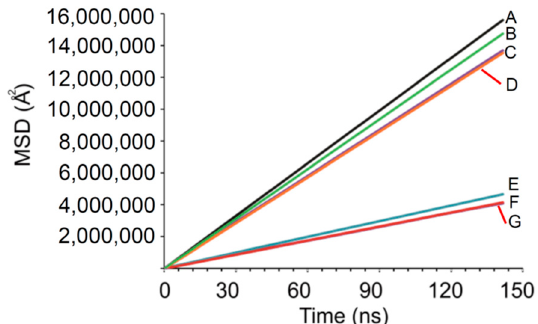
Figure 6. MSD plots of charged (top group curves) and neutral salicylic acid species (bottom group curves) for various compositions as mentioned in the text. A is the system where only charged salicylate beads are present, B charged to neutral salicylic acid beads in 4:1 ratio, C is the system with charged to neutral salicylic beads in 1:1 ratio, D is the 1:4 charged to neutral bead system, E is 1:99 charged to neutral salicylic/particles, F is the fully neutral salicylic acid model.